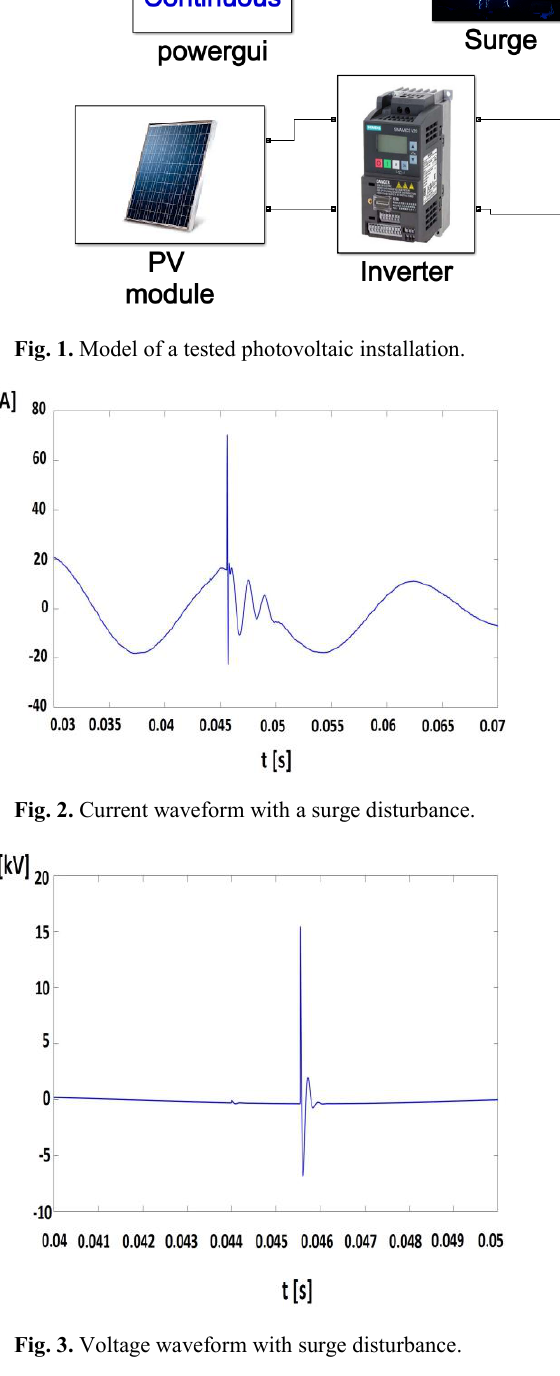
Fig. 3. Voltage waveform with surge